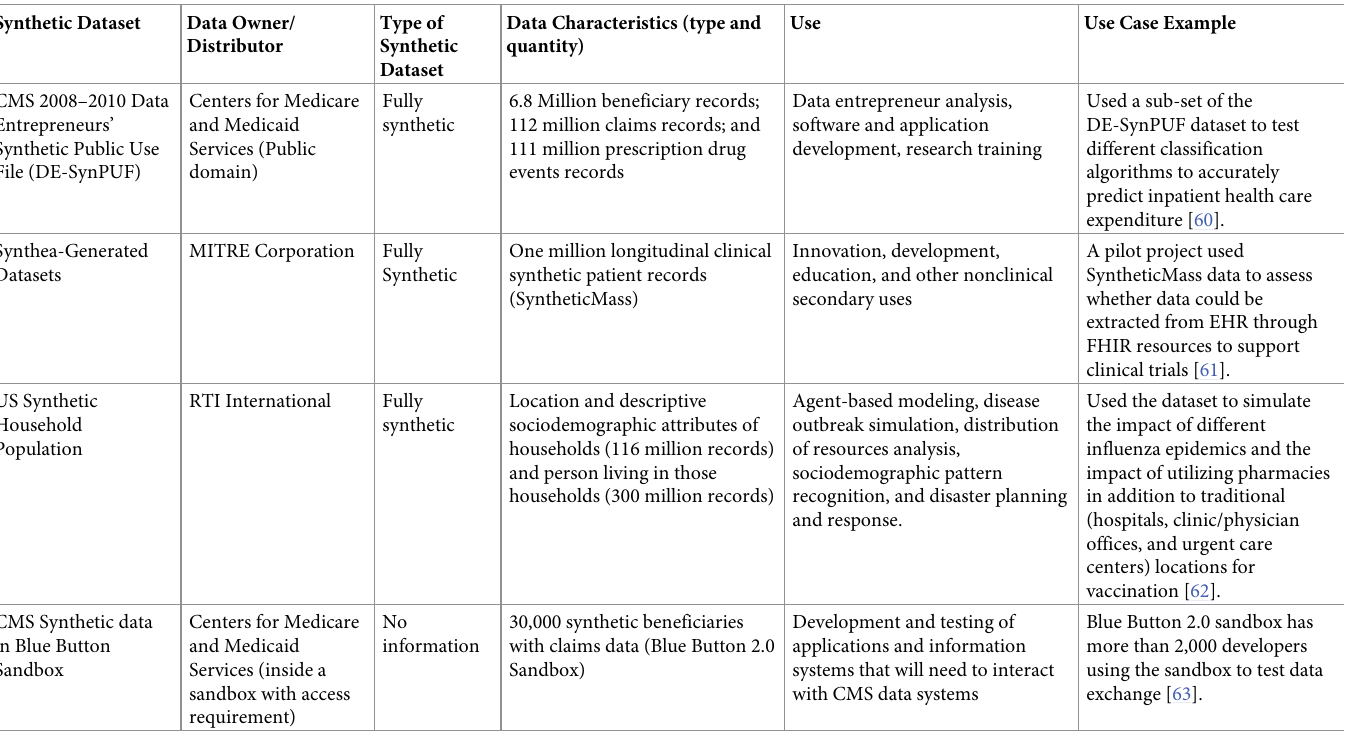
Table 2. Examples of synthetic health datasets and their characteristics. Synthetic